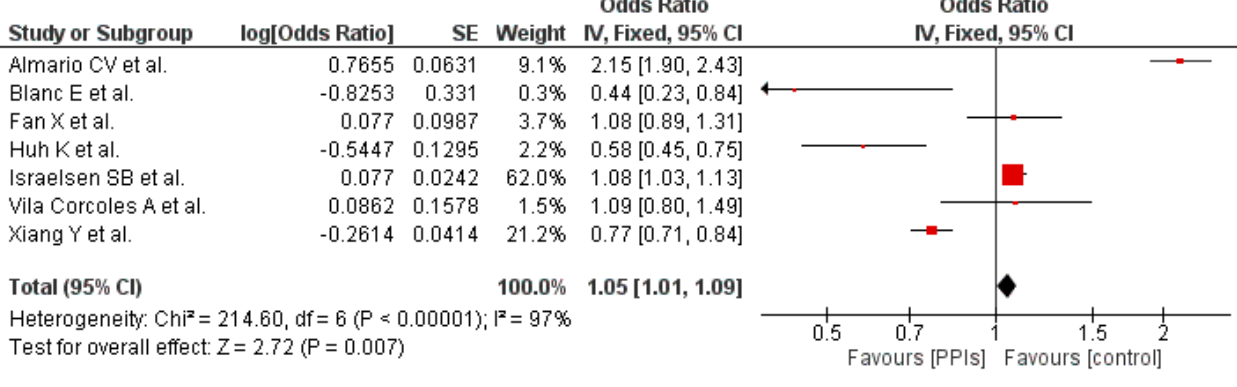
Figure 2. Probability of developing COVID-19 in patients on PPI versus not on PPI.